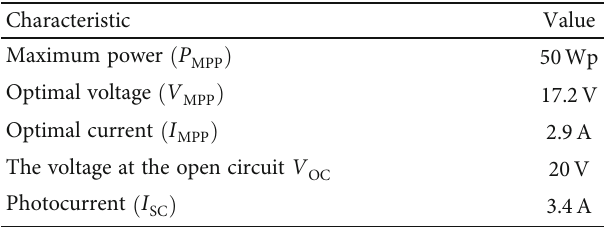
Figure 1: The system architecture of the proposed o ff -grid SPV water pumping system. Table 1: PV module speci fi cations.